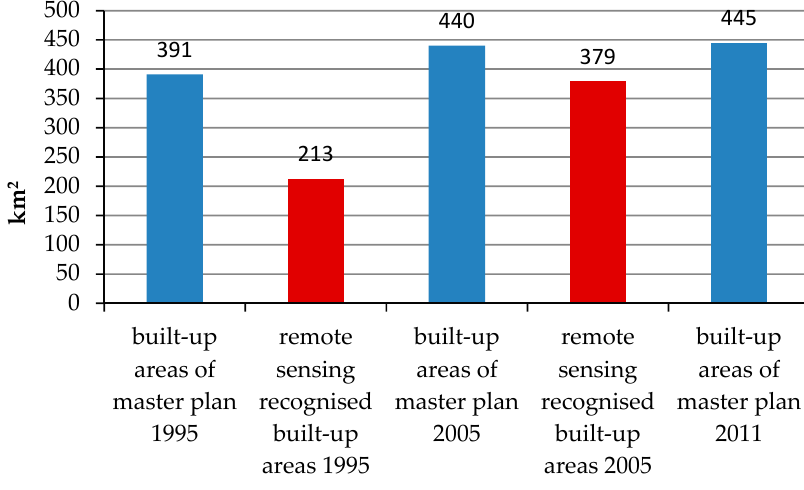
Figure 13. Built-up areas of master plan and built-up areas recognized by using remote sensing images.